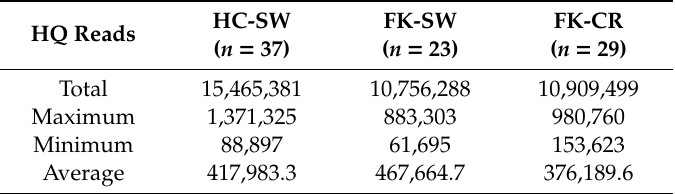
Table 1. High quality reads from 89 ocular fungal microbiomes from conjunctival swabs of healthy controls (HC-SW, n = 37), conjunctival swabs of fungal keratitis patients (FK-SW, n = 23), and corneal scrapings of fungal keratitis patients (FK-CR, n = 29). HQ Reads